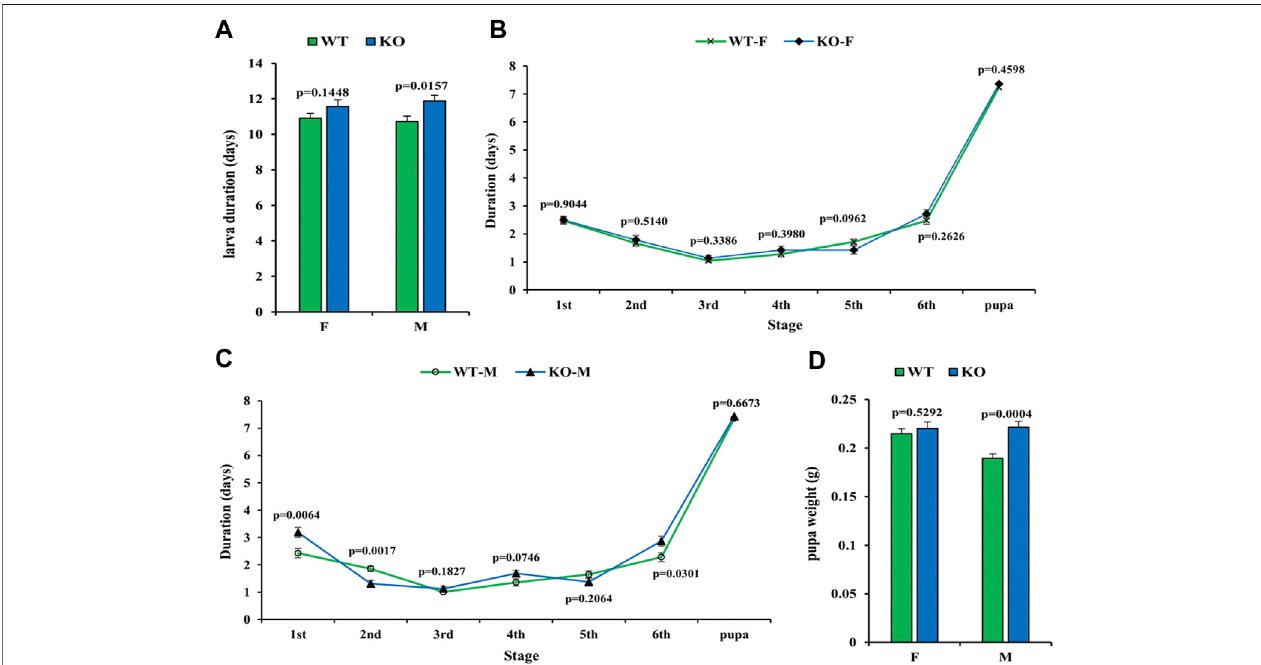
FIGURE 4 | Effect of SfSoxC knockout on the larval development time and pupal weight. The developmental time and pupal weight were determined in SfSoxC knockout fall armyworm. (A) The larval development time (days) between wildtype (WT) and SfSoxC gene knockout (KO) insects showed no signi fi cant difference ( p = 0.1448)infemale (F) ,butshowedsigni fi cantdifference( p =0.0157)inmale(M). (B) Thedevelopmentaltime(days)ateachdevelopmentalstageinfemale(WT-FandKO- F)insects.Thereisnosigni fi cantdifferencebetweenWTandKOinsectsatanydevelopmentalstage. (C) Thedevelopmenttime(days)ateachdevelopmentalstage inmale(WT-MandKO-M)insects.Thereisnosigni fi cantdifferencebetweenWTandKOinsectsat3rd,4th,5thandpupastages.Duringthe1 st and6 th stages,however, the developmental time of the KO-M insects is signi fi cantly longer than that of the WT-M insects. During the 2 nd instar, the developmental time of the KO-M insects is signi fi cantly shorter than that of the WT-M insects. (D) The pupal weight (g) between WT and KO insects has no signi fi cant difference ( p = 0.5292) in female (F), but showed signi fi cant difference ( p = 0.0004) in male (M). Means ± SE of three independent experiments are shown ( p values comes from t tests